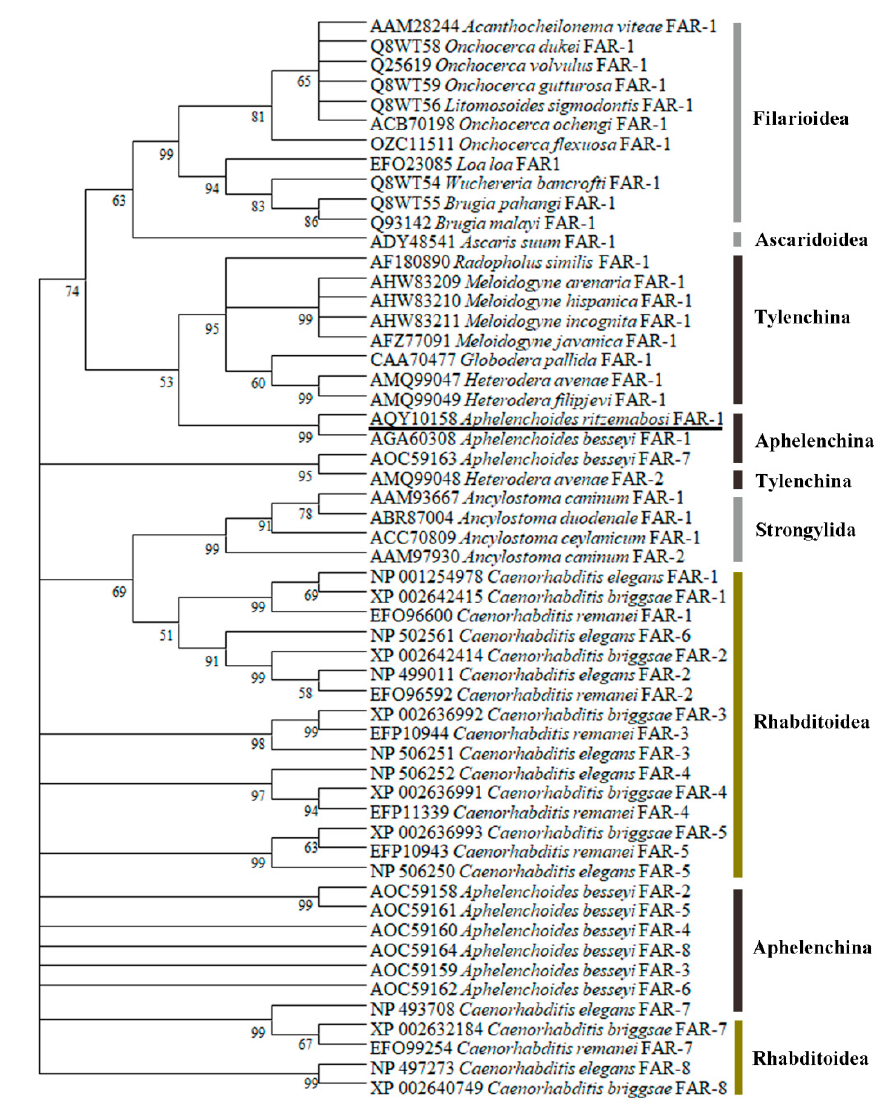
Figure 2. Phylogenetic relationships between Aphelenchoides ritzemabosi Ar -FAR-1 protein and FAR proteins from twenty-eight other nematodes. This phylogram was constructed with the amino acid sequences from 55 FAR proteins from 28 different nematodes using neighbor-joining algorithm to describe their evolutionary relationships. The numbers below the branches indicated the bootstrap values, which were calculated from 1000 replicates. A. ritzemabosi Ar -FAR-1 was underlined.